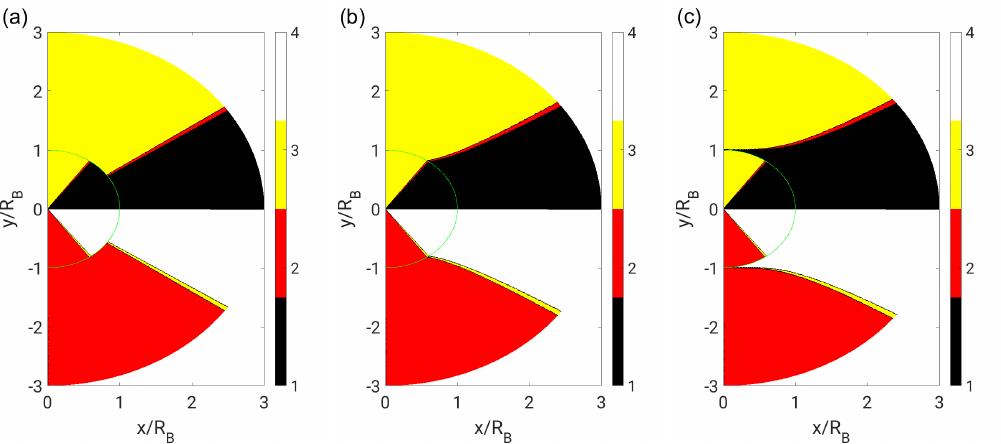
Figure 11. Flow topologies for: ( a ) very small ( ξ = 10 − 5 ); ( b ) identical ( ξ = 1); and ( c ) very large ( ξ = 10 5 ) dynamic viscosity ratios with far-field boundary